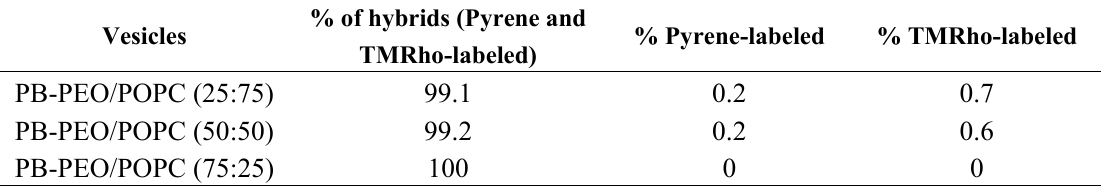
Table 1. Summary of flow-cytometric analysis of vesicle samples of PB-PEO/POPC (25:75); PB-PEO/POPC (50:50); and PB-PEO/POPC (75:25). All vesicles (>99%